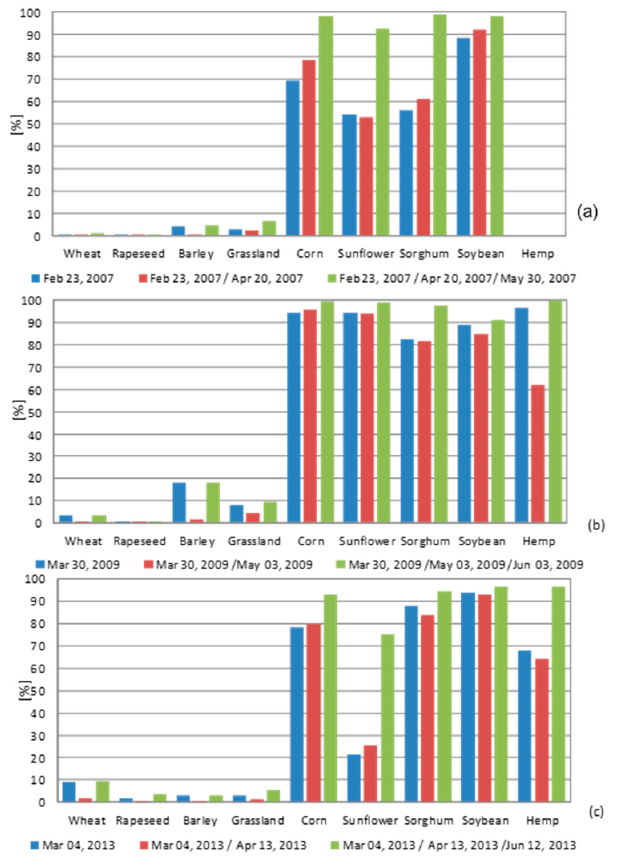
Figure 9. Percentage of pixels detected as summer crops: ( a ) 2007; ( b ) 2009 and ( c ) 2013.